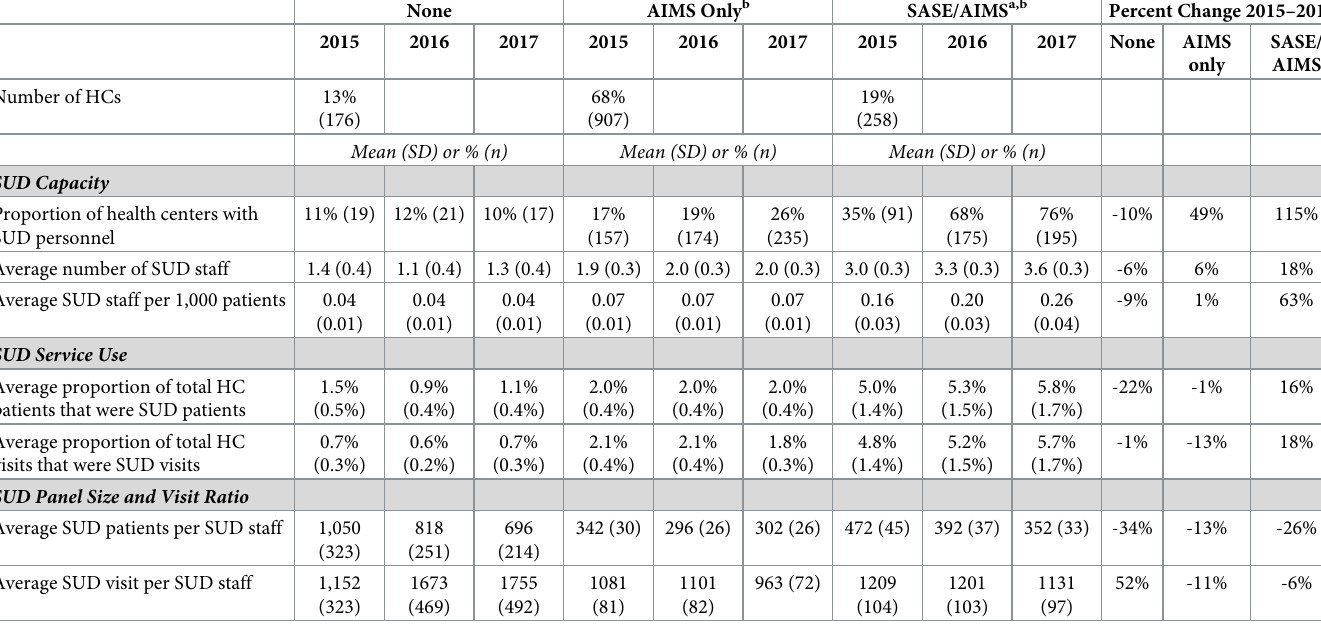
Table 3. Adjusted provision of Substance Use Disorder (SUD) services by federally-funded health centers in the United States between the year prior to grant distri- bution (2015) and the last year the grants were distributed (2017), by grantee